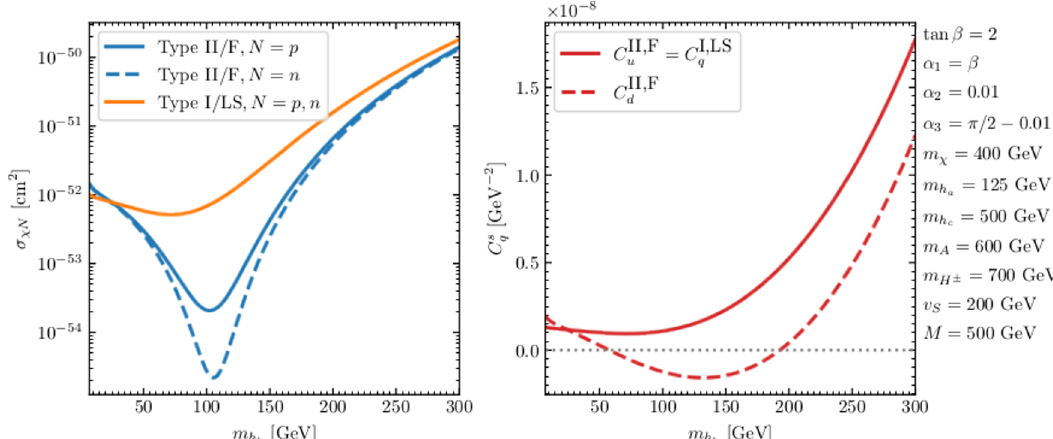
Figure 8 . Left: Cross sections for the scattering of χ on protons ( N = p ) and neutrons ( N = n ) as a function of m h in type I (orange) and type II (blue). Right: Wilson coefficients as defined b in eq. (3.2) and eq. (3.3) as a function of m h . The remaining parameters are fixed to the values b shown on the